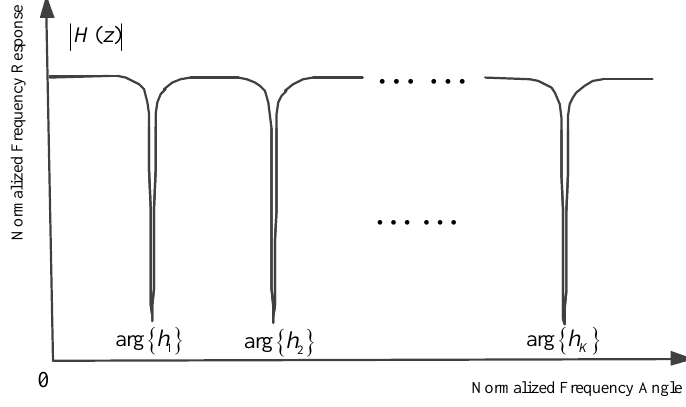
Figure 5. Normalized frequency response of the K order complex-coefficient cyclic cascaded matrix adaptive notch